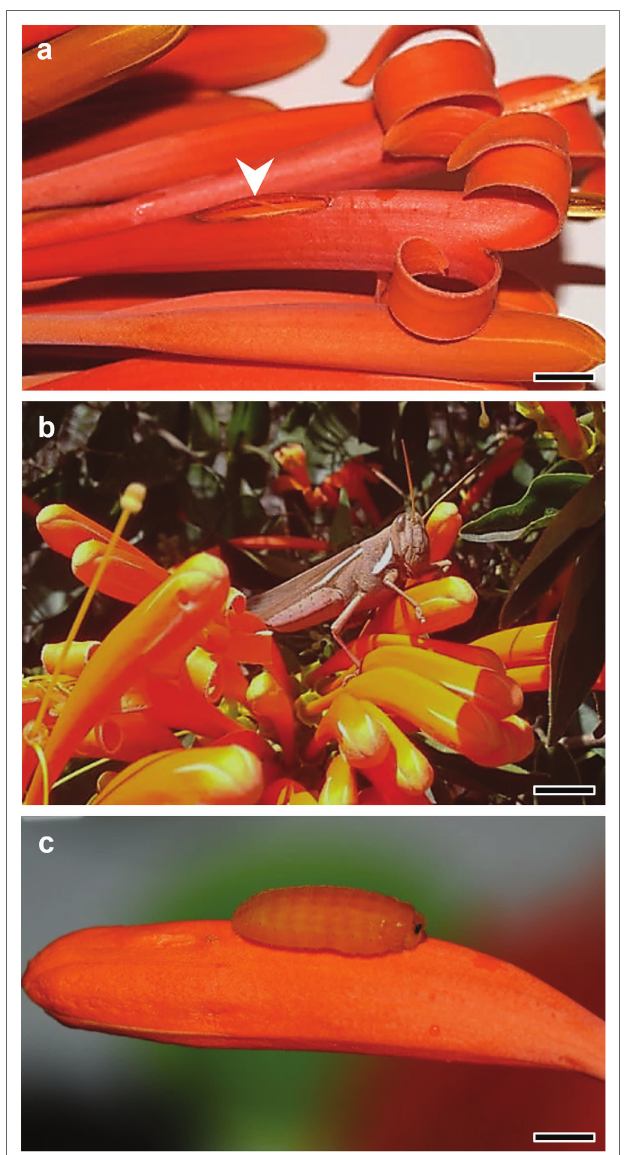
FIGURE 3 | Pyrostegia venusta and its florivores. (A) Natural floral damage (arrowhead) with 1–3% of corolla damage. Scale bar: 0.7 cm. (B) Schistocerca flavofasciata (yellow-lined grasshopper, Acrididae) which consumed the flowers leaving bite marks as shown in Figure 1E . Scale bar: 1.3 cm. Photograph by N. M. Gildo. (C) Parrhasius polibetes (black-spot hairstreak, Lycaenidae) caterpillar, which was the most common florivore in P . venusta . Scale bar: 0.4 cm.